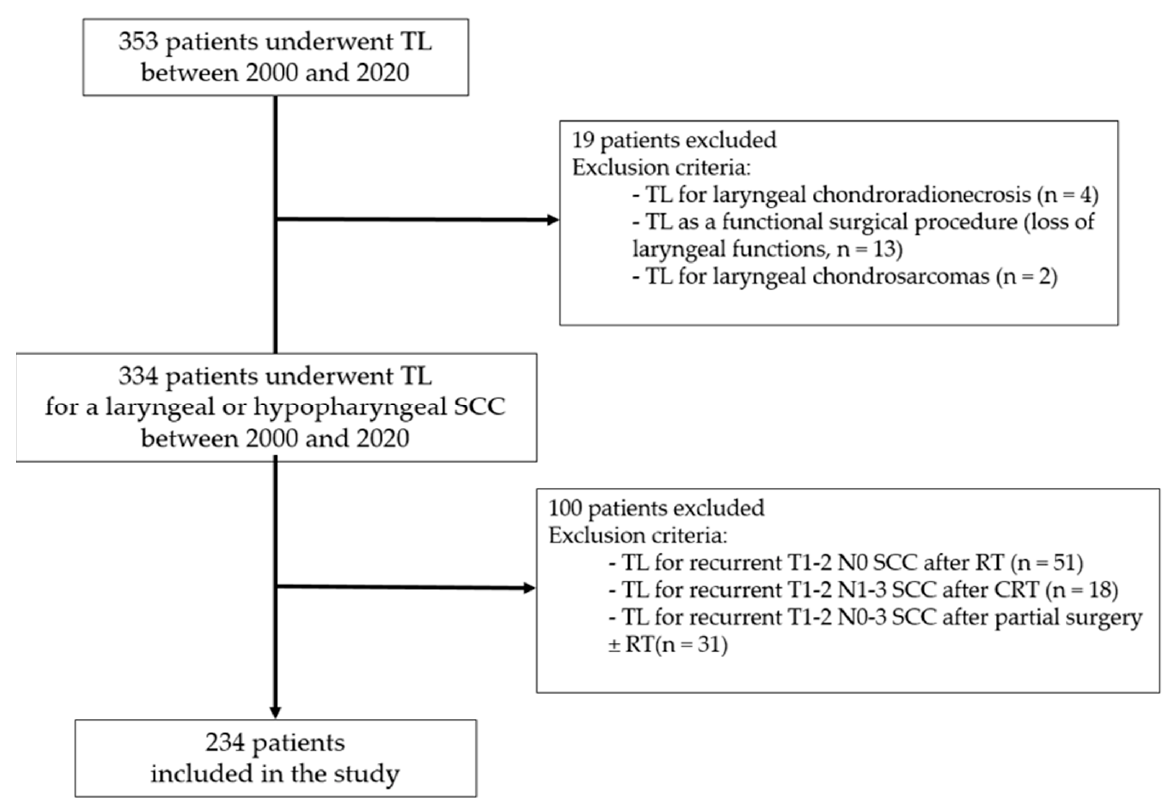
Figure 1. Flowchart of patient selection. TL: total laryngectomy; SCC: squamous cell carcinoma; RT: radiation therapy; CRT: chemoradiation therapy.